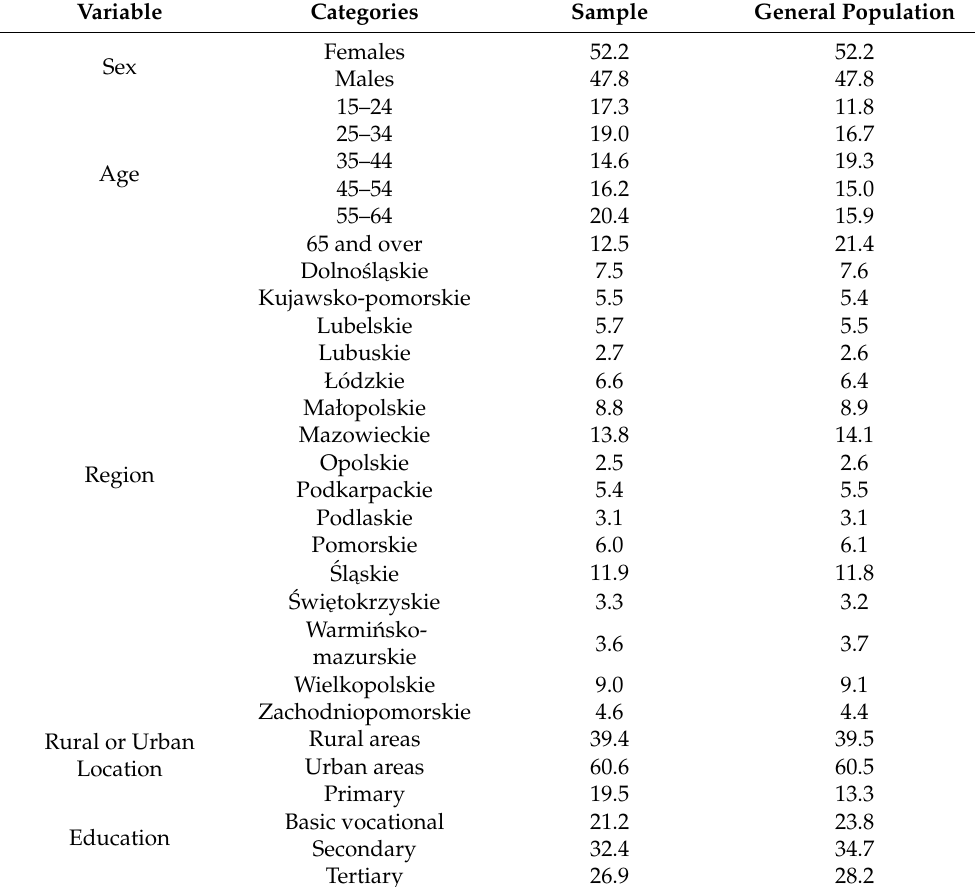
Table 1. A comparison of the sample structure with the general population